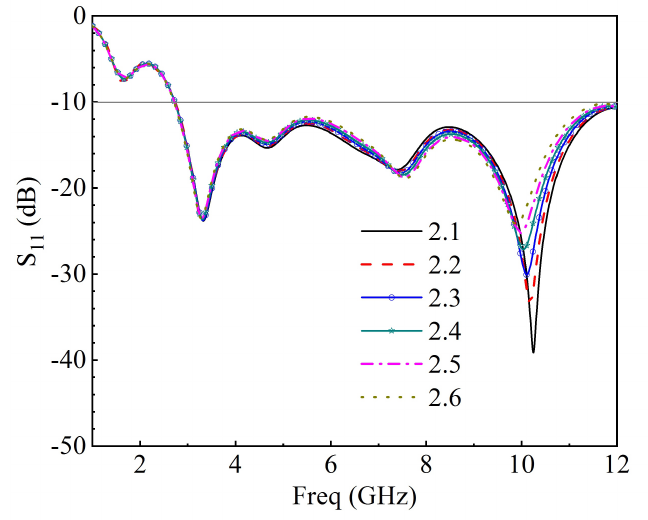
Figure 5. Effect of slot radius on the resonant frequency, R s